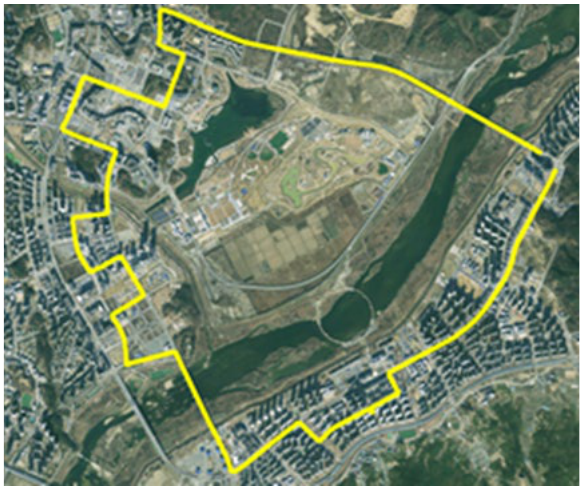
Figure 7. Predefined route for the test drives in Sejong City (Skyview source: Kakao map, National Geographic Information Institute).